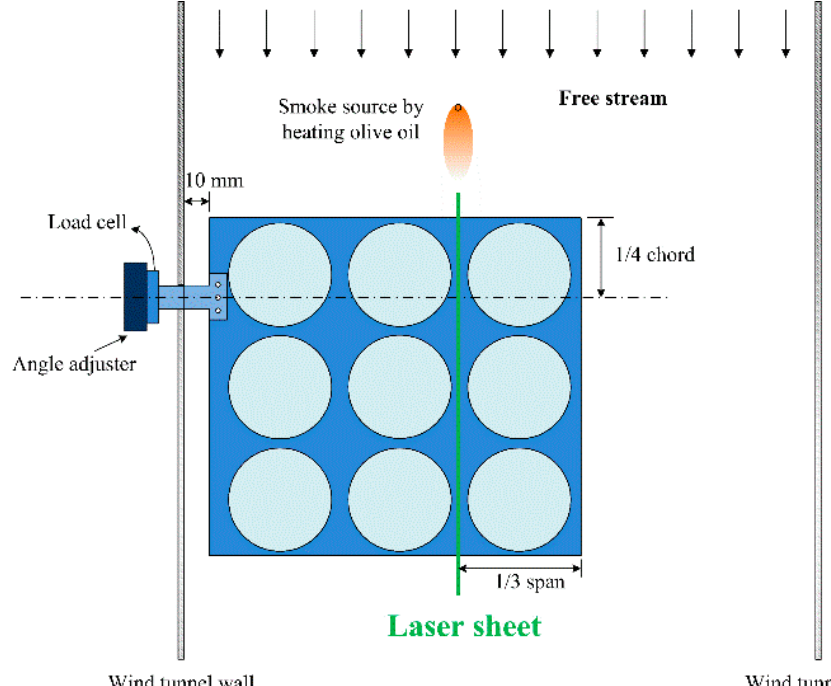
Figure 3. Schematic of the wind tunnel experiment setup.